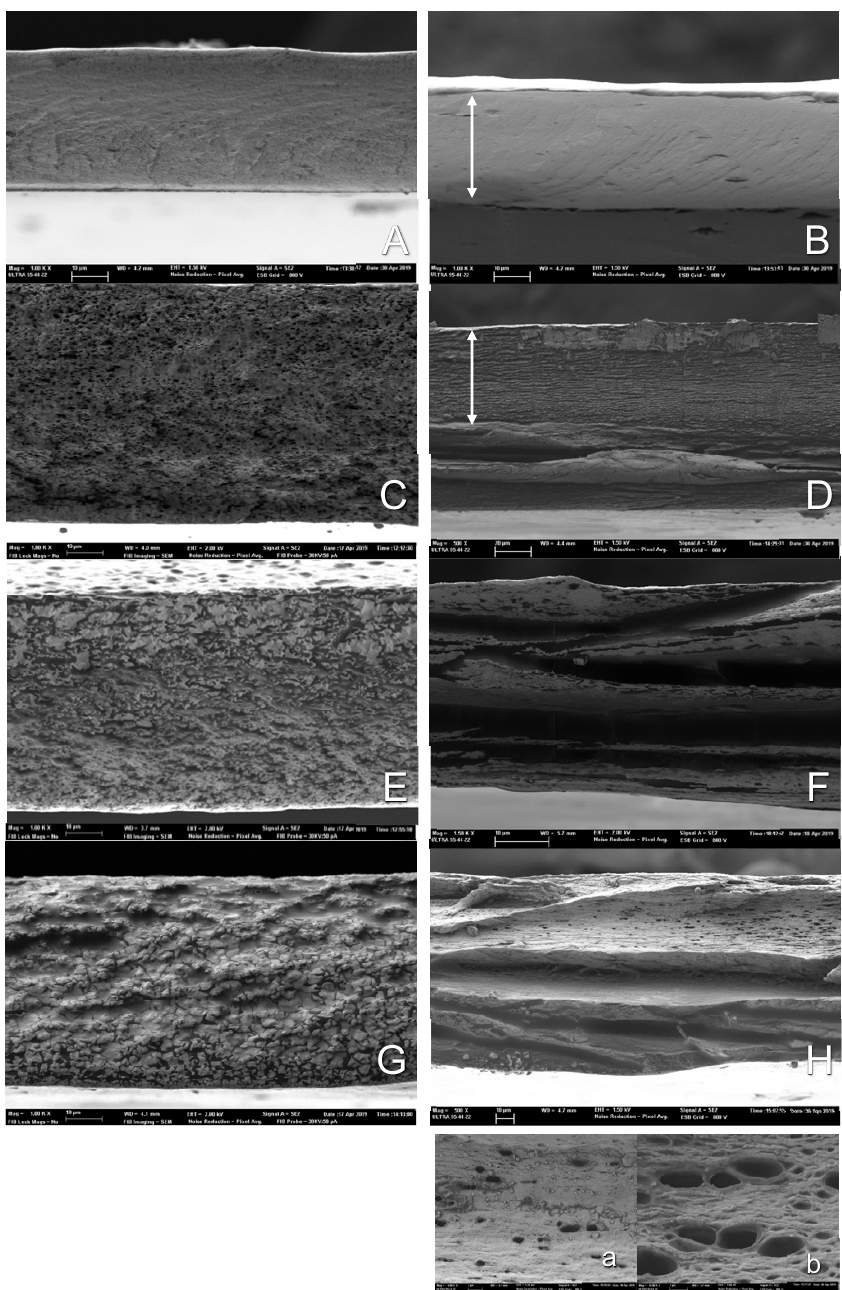
Figure 3. Field Emission Scanning Electron Microscopy (FESEM) micrographs of the obtained films: ( A ) A, ( B ) A-Ca, ( C ) A-T, ( D ) A-T-Ca, ( E ) A-T-LEO L ( F ) A-T-LEO L-Ca ( G ) A-T-LEO H, and ( H ) A-T-LEO H-Ca; a, b—higher magnifications (4,000× and 10,000× respectively) of A-T-LEO H-Ca. White arrows indicate the part of the film cut with a scalpel. All the other samples were cryofractured.